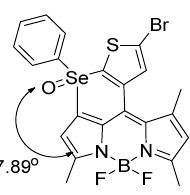
Figure 21. The structure of 5–bromo–p–2–(phenylselanyl)–thiophene–substituted BODIPY and the interfacial angle by Kim et al.